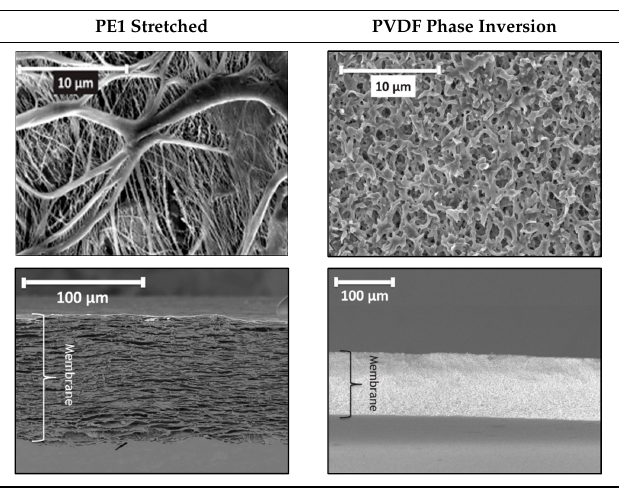
Table 4. SEM (Cold field emission scanning electron microscope) images of PE (polyethylene) and PVDF (polyvinylidene fluoride) commercial hydrophobic membrane.